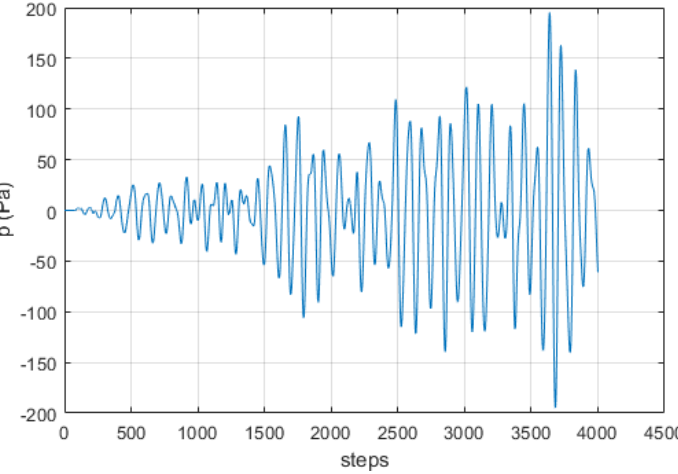
Figure 9. Pressure time history at the point of the novelty of the vertical beam. A characteristic plot of the absolute pressure on the whole domain at time 1.212 ms, corresponding to the highest pressure peak (time step 3638), is shown in Figure 10, where it is evident that the pressure activity is located exactly at the top end of the vertical beam, where the novelty